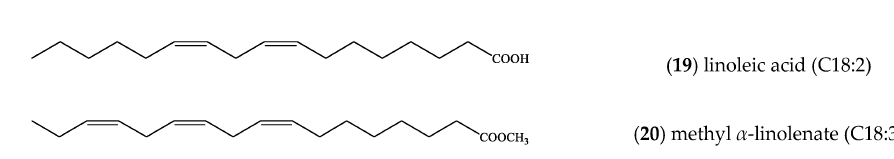
Figure 1. Structures of isolated compounds from Salvia willeana. Table 1. 1 H-NMR and 13 C-NMR spectrum of 11.